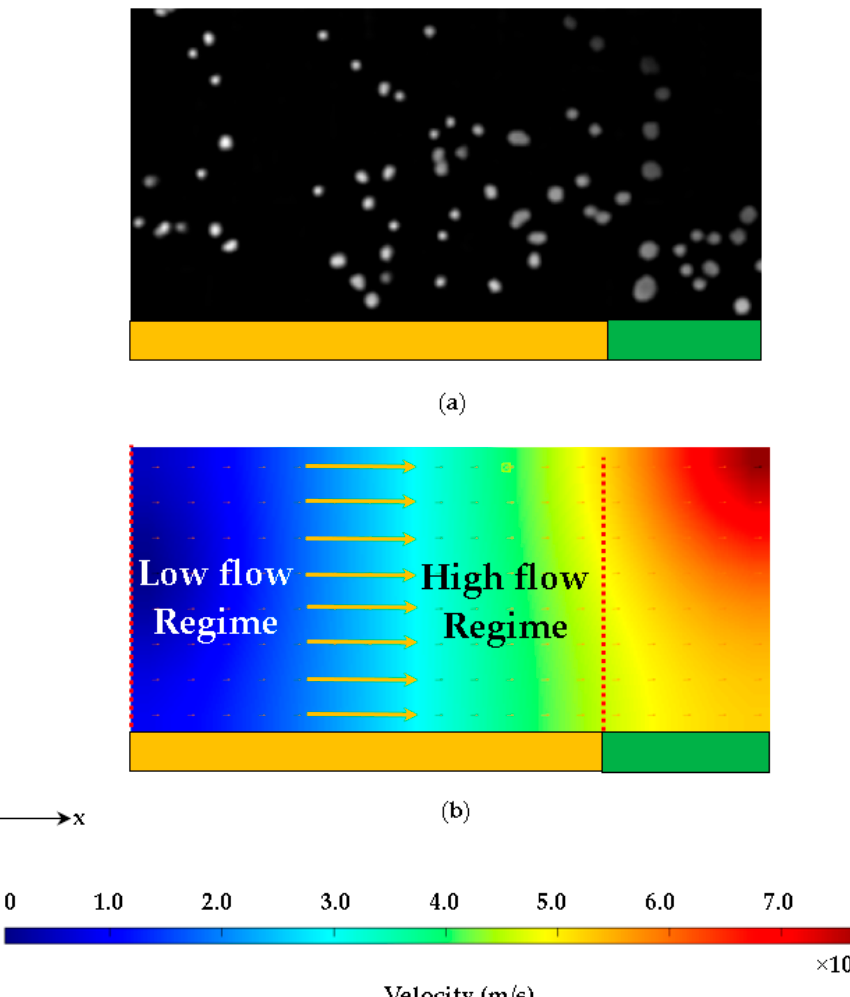
Figure 18. Overview of the particle image processing methodology in PIVlab. ( a ) Top view of 4 µm diameter particles moving in the micro-channel under excitation, and ( b ) The processed velocity contour image. The electrode ( gold ) and spacing ( green ) are shown below the fi gures.